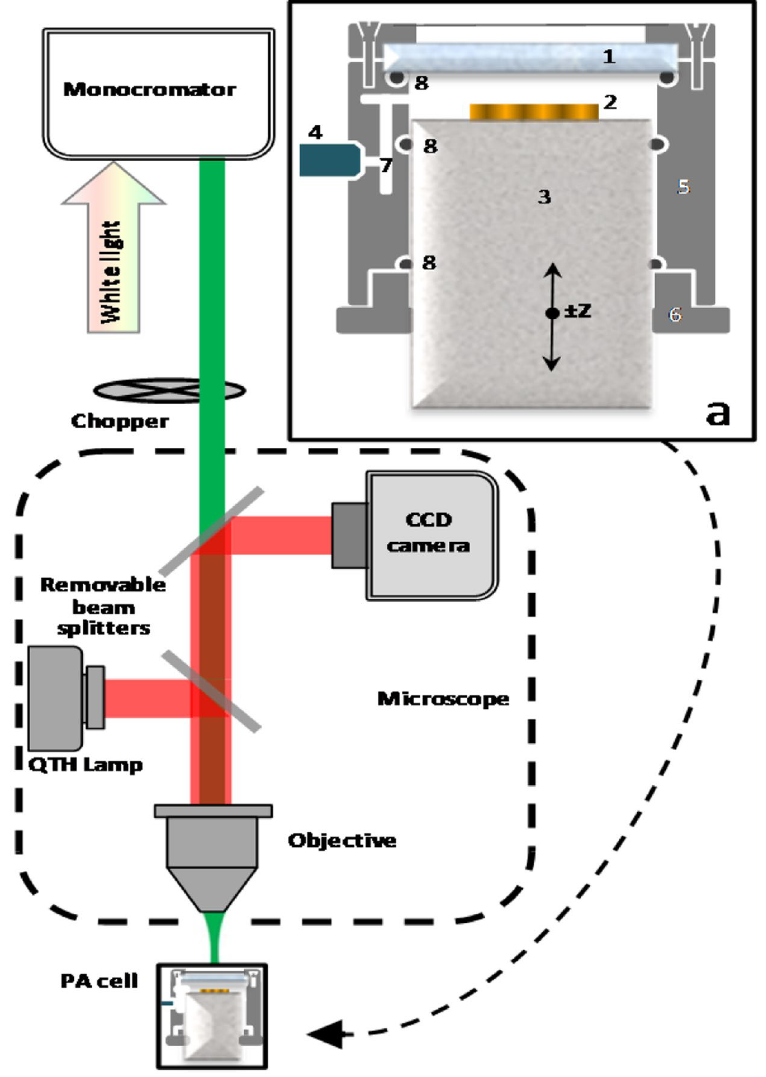
Figure 4. Experimental set-up of the photo-acoustic measurement. Inset ( a ): Variable volume photoacoustic cell, 1-quartz window, 2-sample, 3-quartz cylinder, 4-microphone, 5-inox cell body, 6-threaded flange, 7-sound labyrinth,